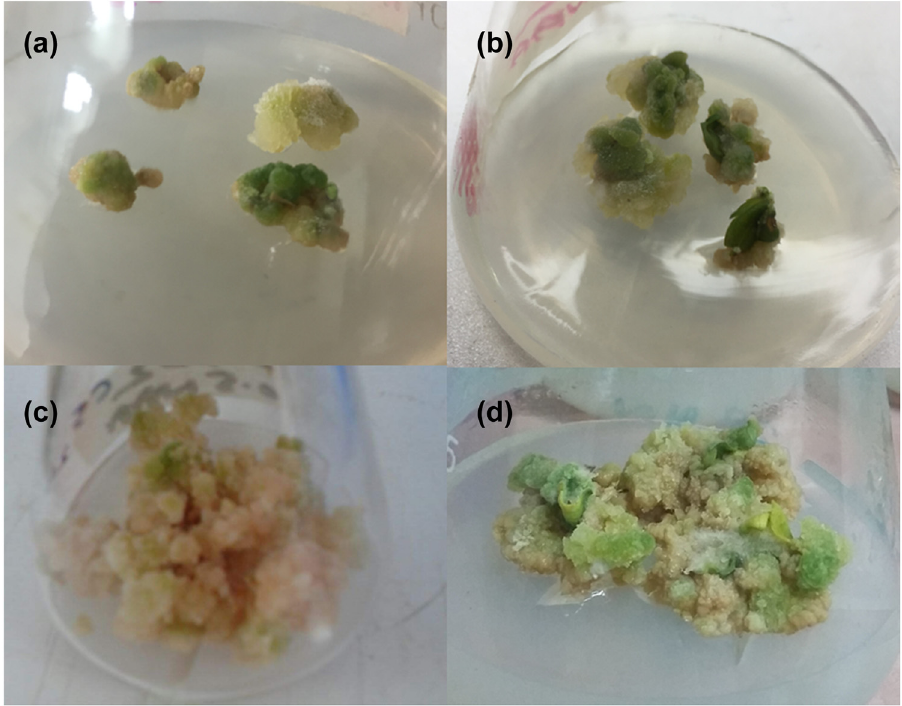
Figure 2: Cannabis sativa callus induction stages: ( a ) initiation of callus, ( b ) callus formation 1.5 weeks after culture, ( c ) growth of the callus, and ( d ) cell death.